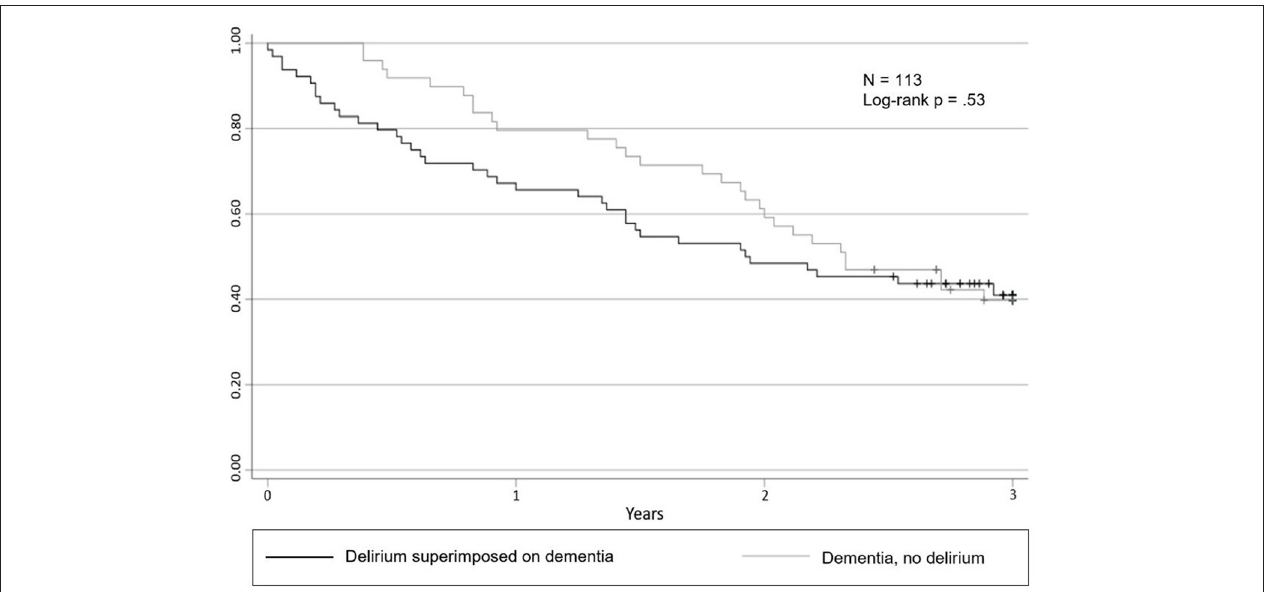
FIGURE 2 | Probability of survival according to delirium and dementia diagnosis. Kaplan-Meier estimates representing the probability of survival after a 3 year observational period according to delirium and dementia diagnosis, with a corresponding log-rank group comparison.